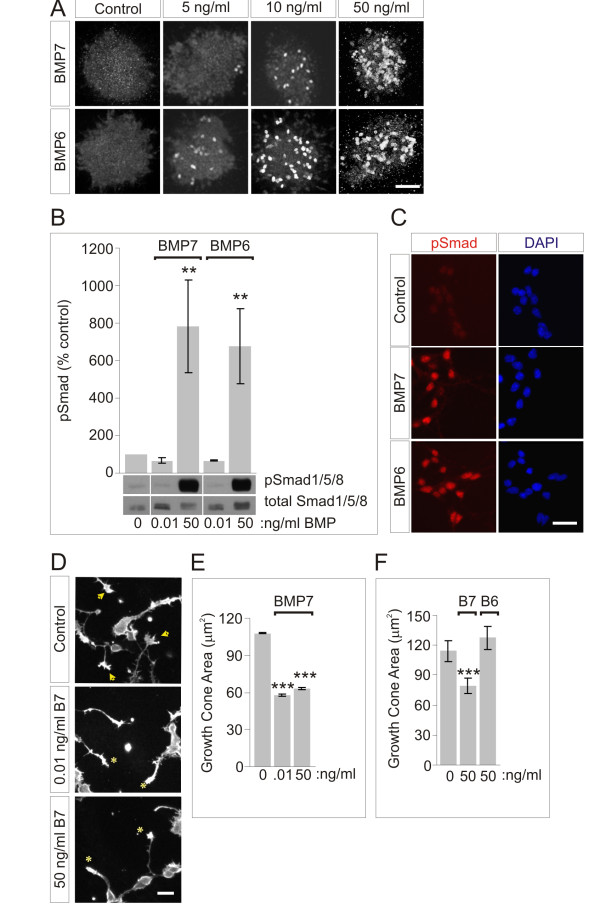
dI induction, Smad activation and growth cone collapse by BMPs. (A) Lhx2/9 induction in [i] explants treated with BMP7 or BMP6. Scale = 50 μm. (B) pSmad1/5/8 response to BMP7 or BMP6 in dI neurons. Western blots of whole cell lysates. Results (mean ± SEM), normalized to total cellular Smad1/5/8, are expressed as percent control pSmad1/5/8 (at 0.01 ng/ml BMP7 = 68 ± 13% and BMP6 = 66 ± 4% (n = 2); at 50 ng/ml BMP7 = 780 ± 247% and BMP6 = 675 ± 199% (n = 5)). Mann-Whitney tests: the pSmad1/5/8 response at 50 ng/ml BMP7 and BMP6 was significantly different from control (**P < 0.01); the pSmad1/5/8 response at 0.01 ng/ml BMP7 and BMP6 was not different from control (P = 0.0952). (C) Dissociated dI neurons ±50 ng/ml BMP7 or BMP6, double-labeled with phospho-specific α-Smad1/5/8 (red) and DAPI (blue): 95.2 ± 2.0% (BMP7) and 97.9 ± 1.5% (BMP6) dI neurons were pSmad1/5/8+. Scale = 20 μm. (D) ERM)-labeled dissociated dI neurons ±BMP7 at 0.01 or 50 ng/ml. Arrowheads indicate typical widespread growth cones and asterisks indicate collapsed growth cones. Scale = 20 μm. (E) Average growth cone areas (mean ± SEM): control = 107.6 ± 0.44 μm2; BMP7 (0.01 ng/ml) = 57.8 ± 1.11 μm2; BMP7 (50 ng/ml) = 63.4 ± 0.85 μm2. Areas measured in 0.01 or 50 ng/ml BMP7 differ significantly from control (***P < 0.001, Student's t-test). Results are for 140 to 380 growth cones/condition/experiment; n = 2. (F) Comparison of dI growth cone responses to BMP7 and BMP6 (50 ng/ml), measured as in (E): control = 114.3 ± 10.7 μm2; BMP7 = 79.5 ± 7.4 μm2; BMP6 = 127.4 ± 11.9 μm2. Student's t-tests: area in BMP7 differs significantly from control (***P < 0.001); area in response to BMP6 was not different from control (P = 0.0607). Results are for 100 to 115 growth cones/condition/experiment; n = 2.